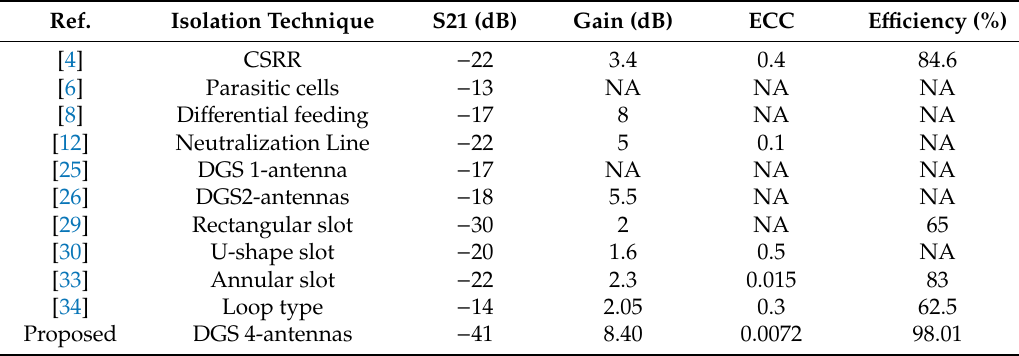
Figure 10. Envelope correlation coefficient. Table 2. Performance comparisons with the related